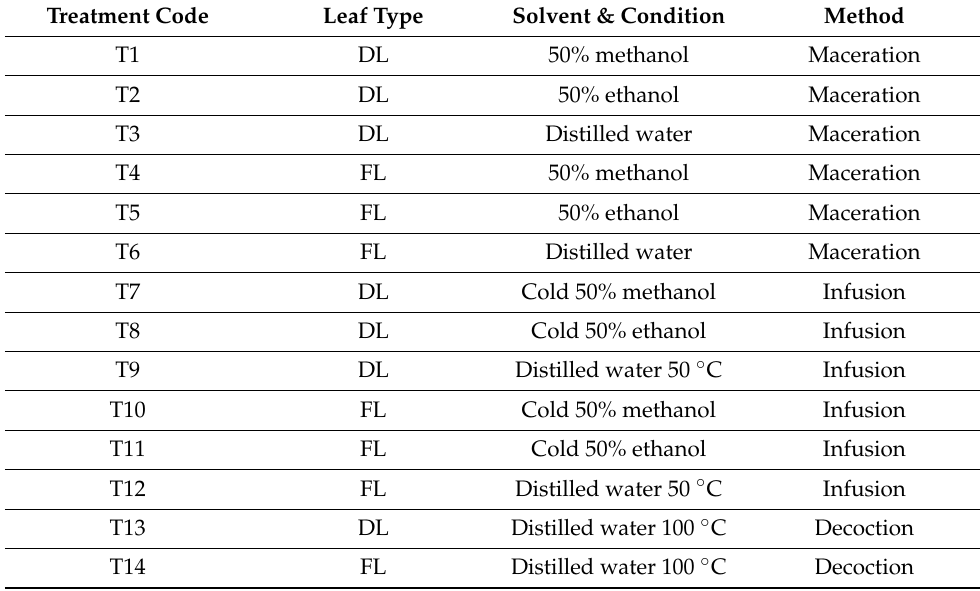
Table 1. Moringa leaf extraction